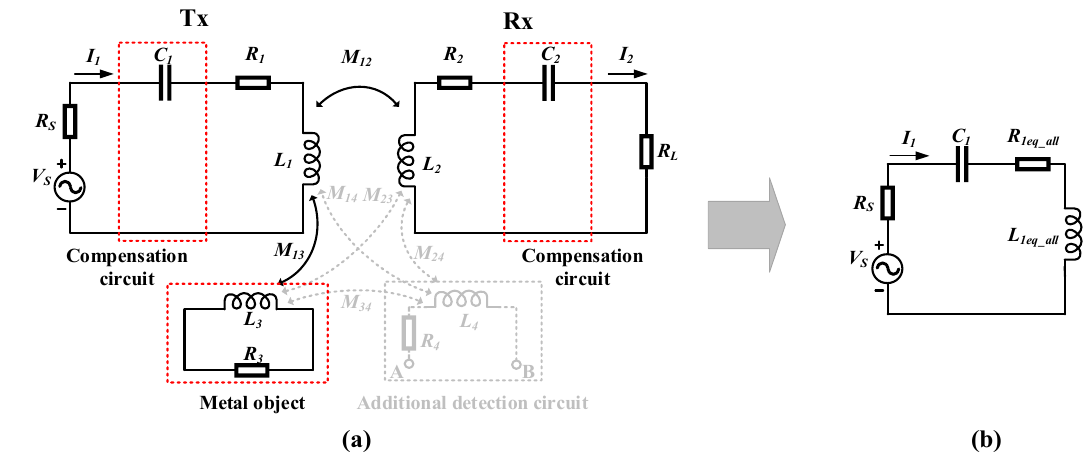
Figure 7. ( a ) Complete circuit, ( b ) simplified equivalent circuit of the WPT system with the reflected metal object and receiver.